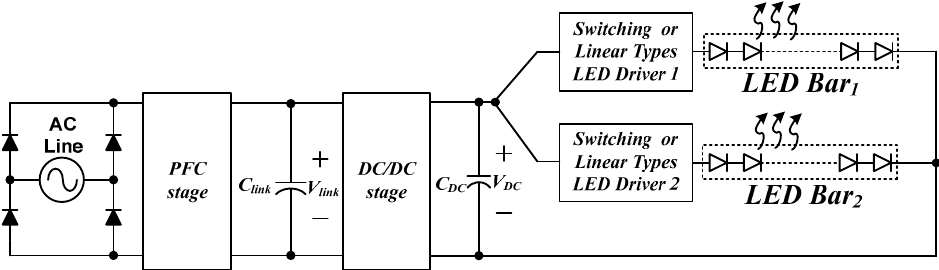
Figure 1. General power conversion circuit for high-power light emitting diode (LED) strings.